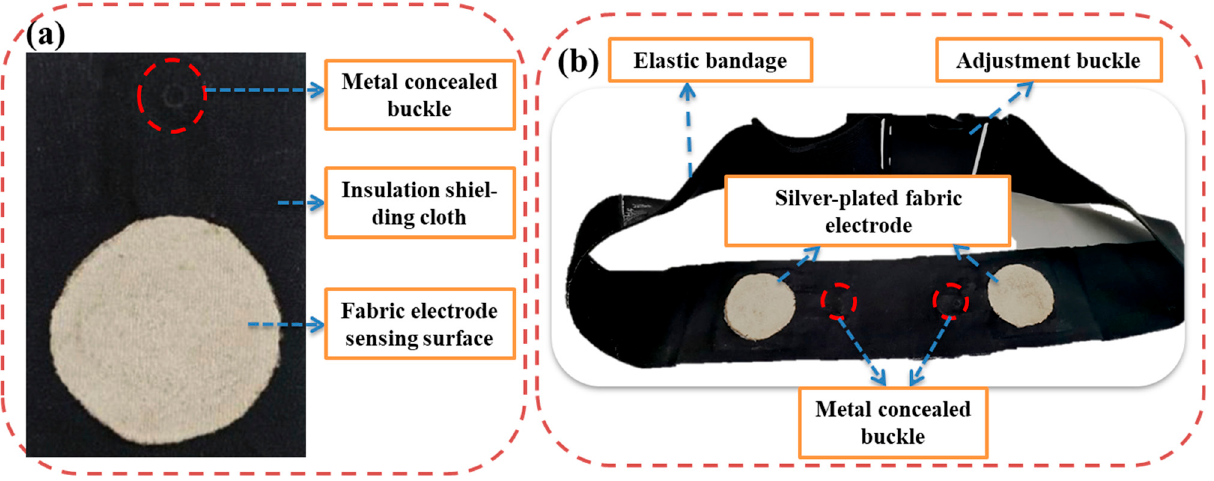
Figure 1. ( a ) Fabric electrode structure diagram. ( b ) Fabric ECG belt structure diagram.